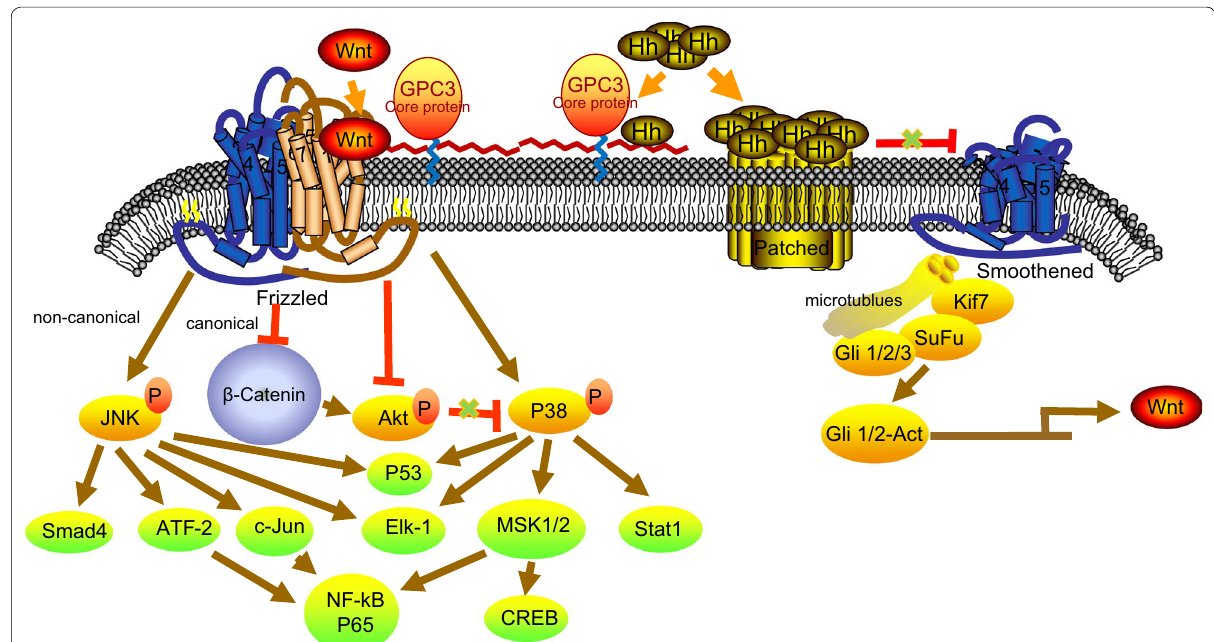
Fig. 1 Positive and negative effects of GPC3 on its two main signaling pathways. In the Wnt signaling pathway ( left ), GPC3 suppresses canonical Wnt signaling pathway (Wnt/β-catenin) while motivating the activation of non-canonical Wnt signaling pathway (Wnt/JNK). In the Hedgehog (Hh) signaling pathway ( right ), this signaling pathway can be triggered by combination of Hh and the receptor Patched (Ptc) which leads to the inhibi- tion of Ptc on Smoothened. GPC3 competes with Ptc for Hh